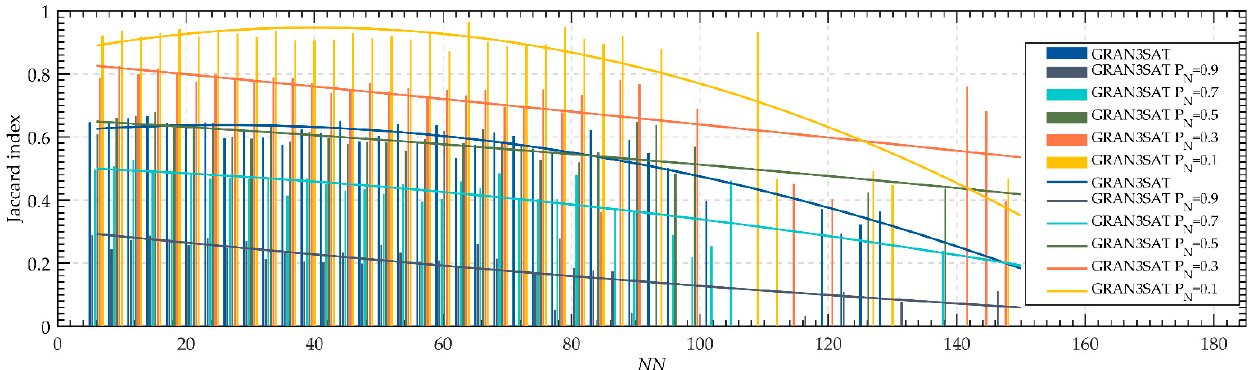
Figure 8. S for GRAN3SAT for different values of Jaccard Figure 8. S Jaccard for GRAN3SAT for different values of P N . Table 13. The ranges of the S Jaccard values. Table 13. The ranges of the S values. Jaccard Case